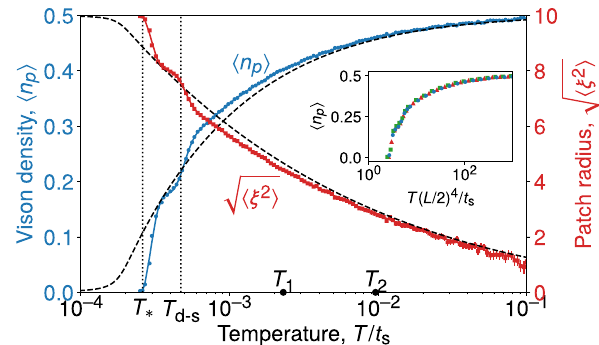
Fig. 2 Evolution of equilibrium vison density. We show the average vison density per plaquette, 〈 n p 〉 (blue circles, left vertical scale), and the typical ffiffiffiffiffiffi p (red squares, right vertical scale) as a vison-depleted patch radius h ξ 2 i function of temperature. The numerical data are compared with the predictions (dashed lines) of the circular disc free energy given in Eq. (3). As temperature is lowered, the fi nite system makes a transition to a system-spanning strip state (see Supplementary Note 2) at a temperature T T d-s , and becomes vison-free below * . The solid lines through the MC data are a guide to the eye. The calculations were performed on a system of size L 2 = 20 2 satisfying periodic boundary conditions. The inset shows a scaling collapse of 〈 n p 〉 as a function of T ( L /2) 4 / t s for L = 16 (green squares), 18 (red triangles), 20 (blue